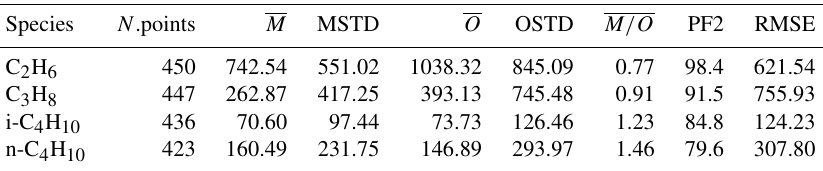
Table 4. Summary of simulated and observed mixing ratios of different tracers in the NOAA/INSTAAR database (station observations). The columns are the same as in Table